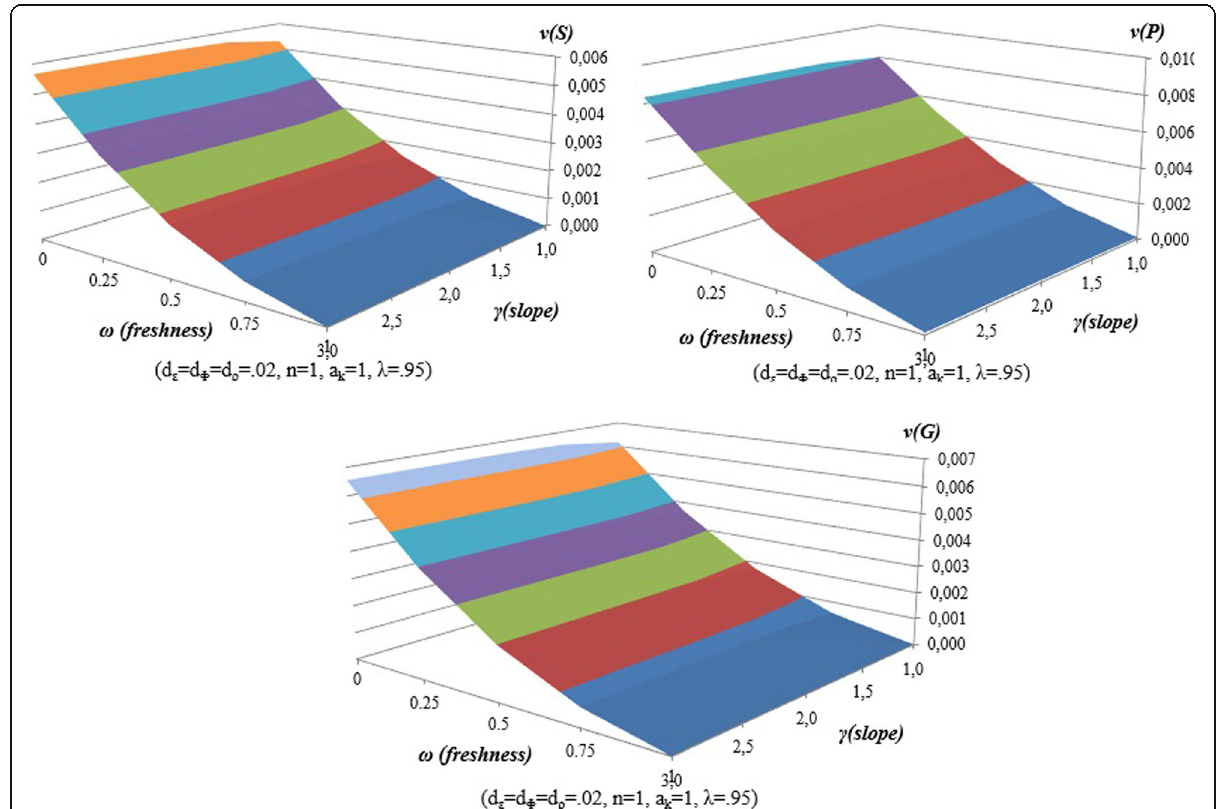
Fig. 2 Upper bounds of security v(A S ), privacy v(A P ) and service v(A G ) risks for various slope ( γ ) and freshness ( ω )